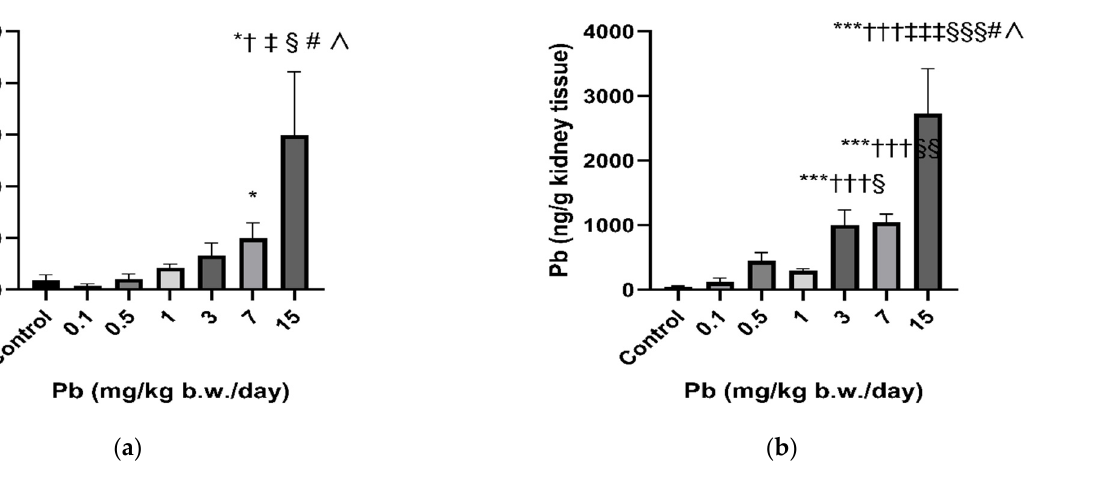
Figure 1. Liver ( a ) and kidney ( b ) Pb levels in Wistar rats subacutely exposed to low levels of Pb over a period of 28 days. Results are presented as means ± SD. * † ‡ § # ∧ p < 0.05; §§ p < 0.01; *** ††† ‡‡‡ §§§ p < 0.001 compared to control, 0.1, 0.5, 1, 3, and 7 group, respectively, using ANOVA followed by Fisher’s LSD